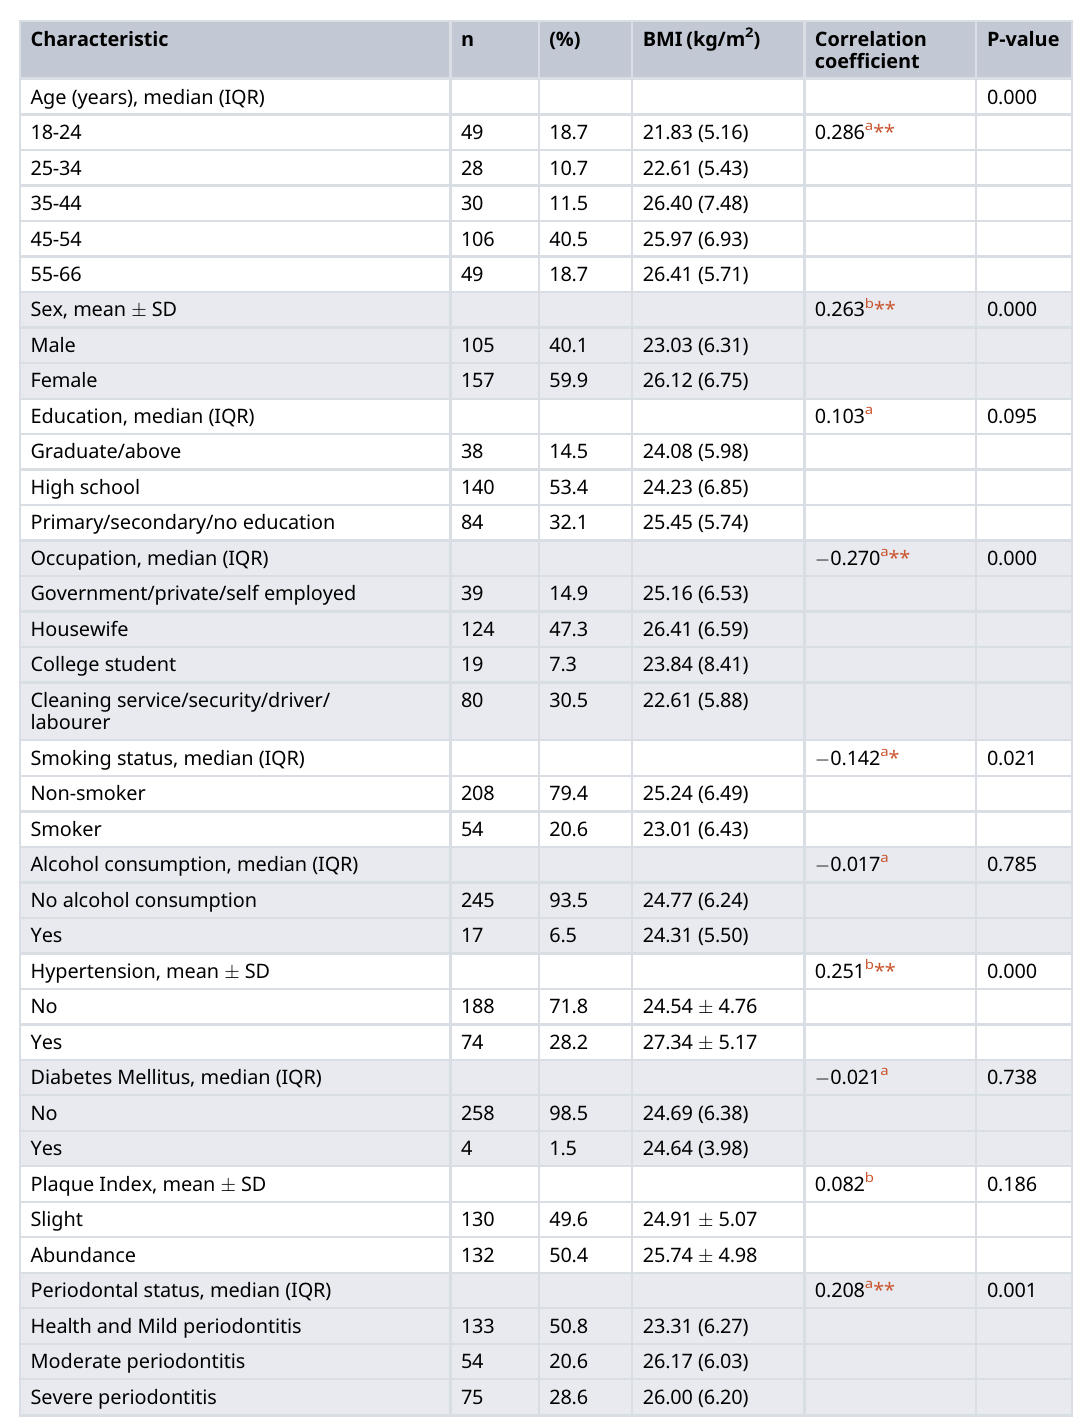
Table 1. Correlation between socio-demographic data, oral hygiene and continuous data of body mass